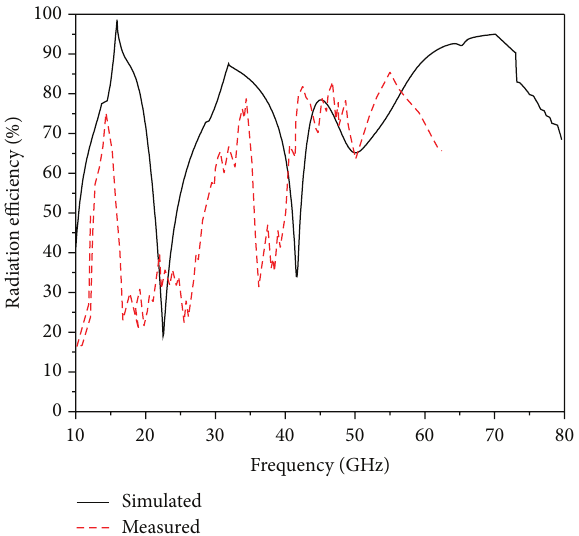
Figure 8: The proposed antenna radiation efficiency versus fre-